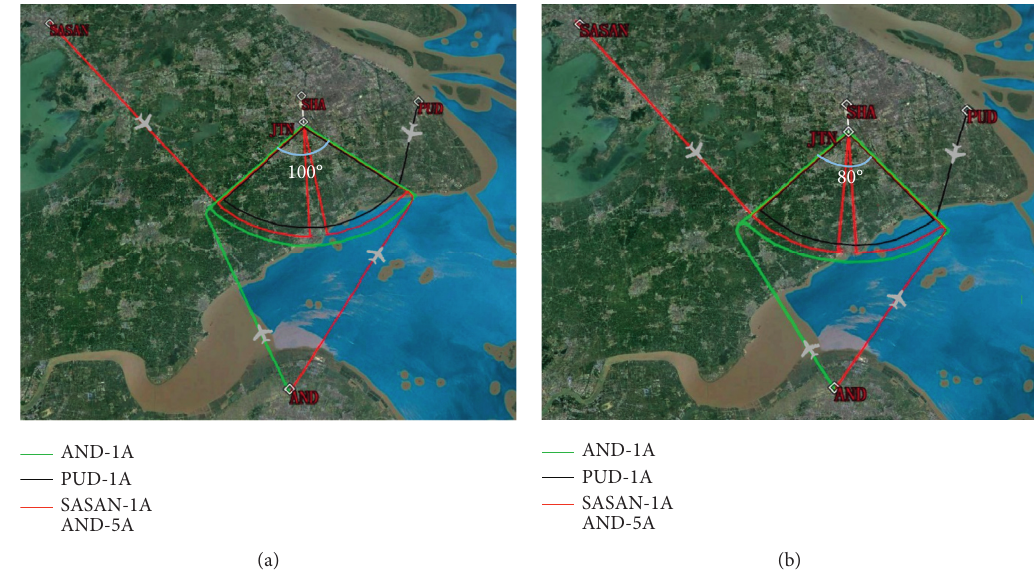
Figure 14: Comparison of two different PM procedures on Google Earth. (a) Initial PM procedure. (b) Optimized PM procedure.